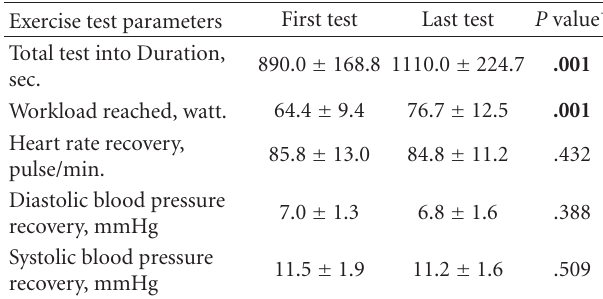
Table 6: Exercise test parameters in aerobic group. Exercise test